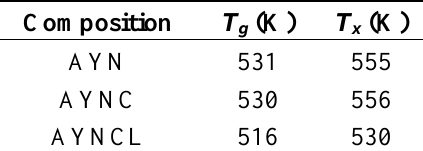
Table 1. T g and T x of the ribbons with three compositions, Al 85.4 Y 10 Ni 5.5 (AYN),